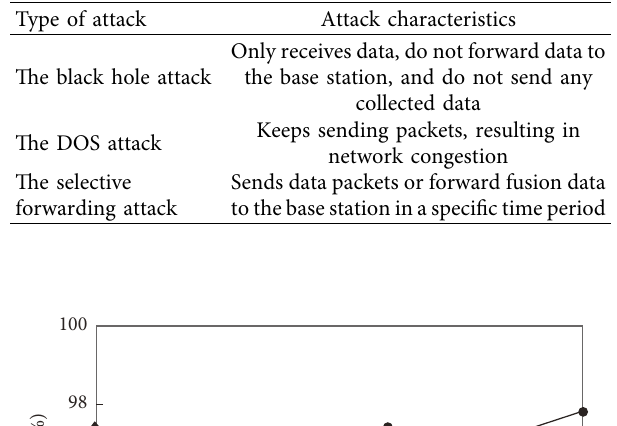
Table 2: Information table of three attack characteristics.